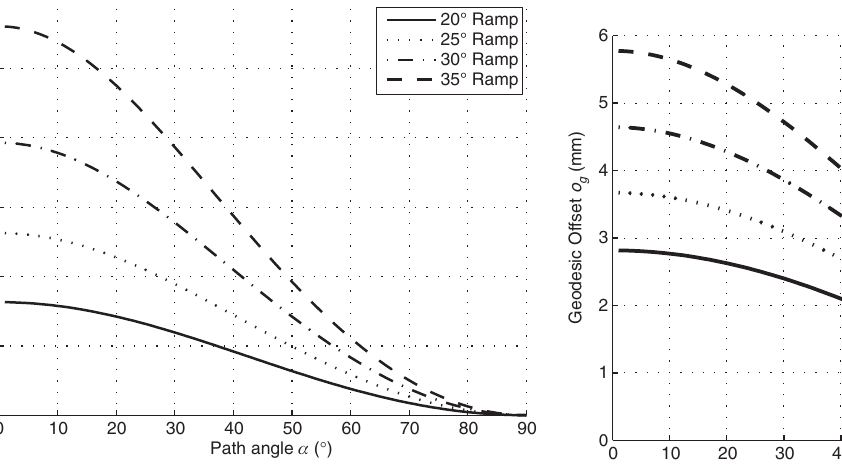
Figure 11 Resulting gap width g different ramp angles.